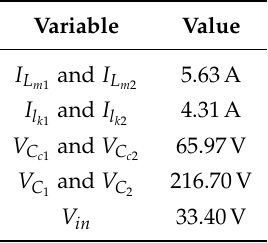
Table 3. Steady-state